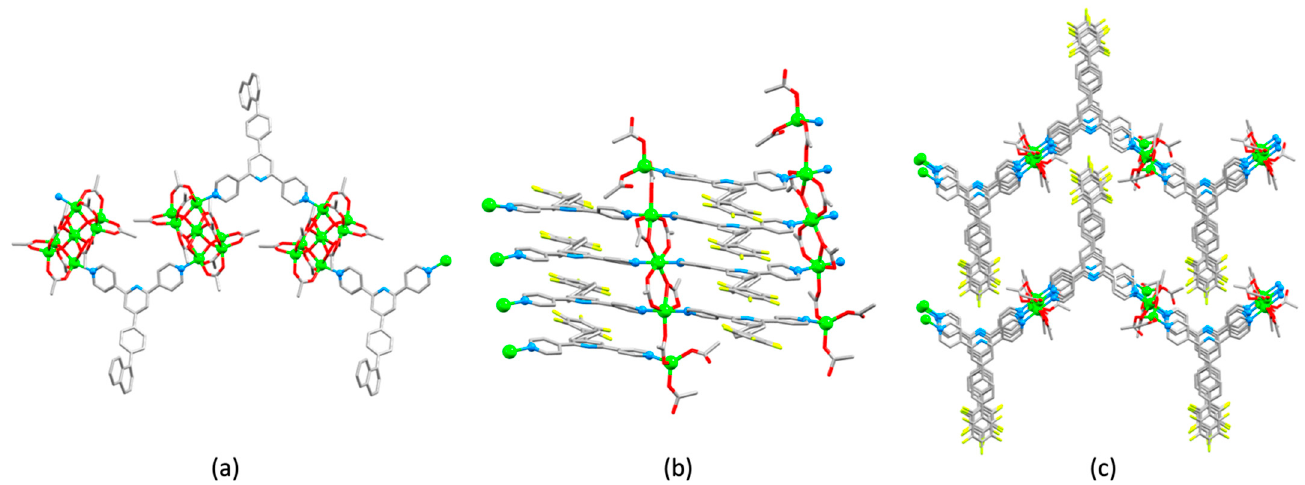
Figure 19. ( a ) Part of one helical chain in [2{Zn 7 ( µ -OAc) 10 ( µ 4 -O) 2 ( 22 )}] n · n CH 2 Cl 2 (CSD refcode OFIWAD). ( b ) Part of the Figure 19. (a) Part of one helical chain in [2{Zn 7 ( μ‐ OAc) 10 ( μ 4 ‐ O) 2 ( 22 )}] n . n CH 2 Cl 2 (CSD refcode OFIWAD). (b) Part of the 1D, quadruple ‐ stranded chain in [Zn 5 (OAc) 10 ( 23 ) 4 ] n . 11 n H 2 O (refcode QIJHEY) and (c) packing of adjacent chains to form a 1D, quadruple-stranded chain in [Zn 5 (OAc) 10 ( 23 ) 4 ] n · 11 n H 2 O (refcode QIJHEY) and ( c ) packing of adjacent chains to form a thick 2D ‐ sheet (compare with Figure 15). thick 2D-sheet (compare with Figure